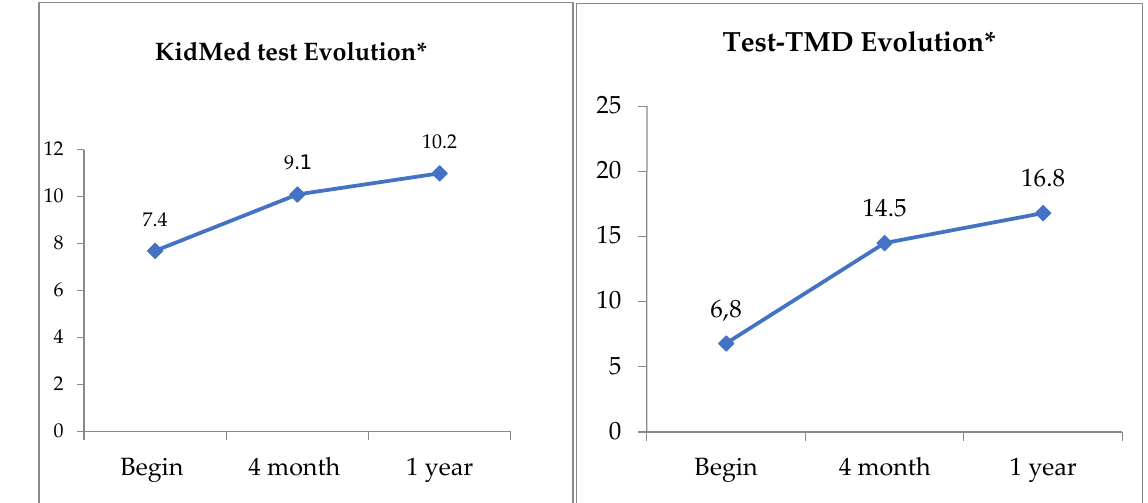
Figure 2. Evolution of the KidMed Test and Test-TMD. * KidMed and TMD index score. At the beginning of the program, 70% of the patients obtained an optimal score on the KidMed test (above 8 points). This rose to 90% by the end of the study. In the TMD-test, only 10% of patients obtained an acceptable score at the beginning of the study. This progressed satisfactorily, until reaching an average score classified as optimal (above 16 points) (Figure 3). We carried out both tests, because in previous studies we observed that the KidMed test was not sensitive to the changes that we promoted in infant feeding, while the TMD test did reflect these proposed changes.